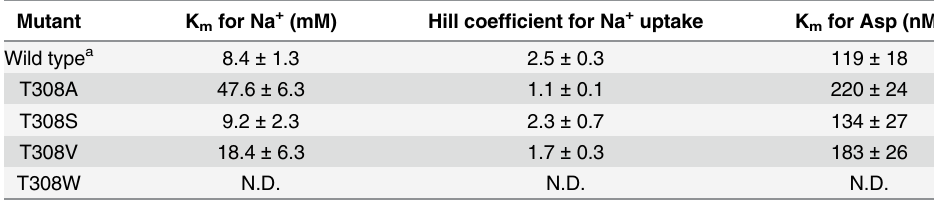
Table 1. Transport of Na + and L-Asp in GltPh.